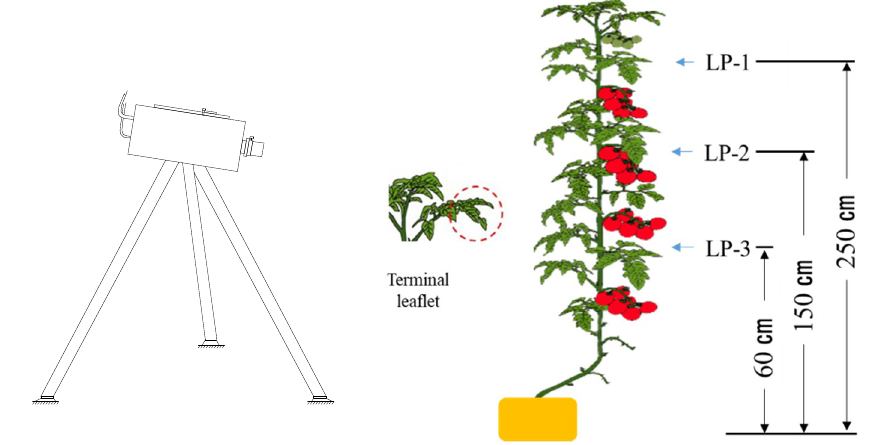
Figure 1. Overview of the tomato leaf sampling at varying leaf positions (LPs). LP-1: Top; LP-2: Middle; LP-3: Bottom.